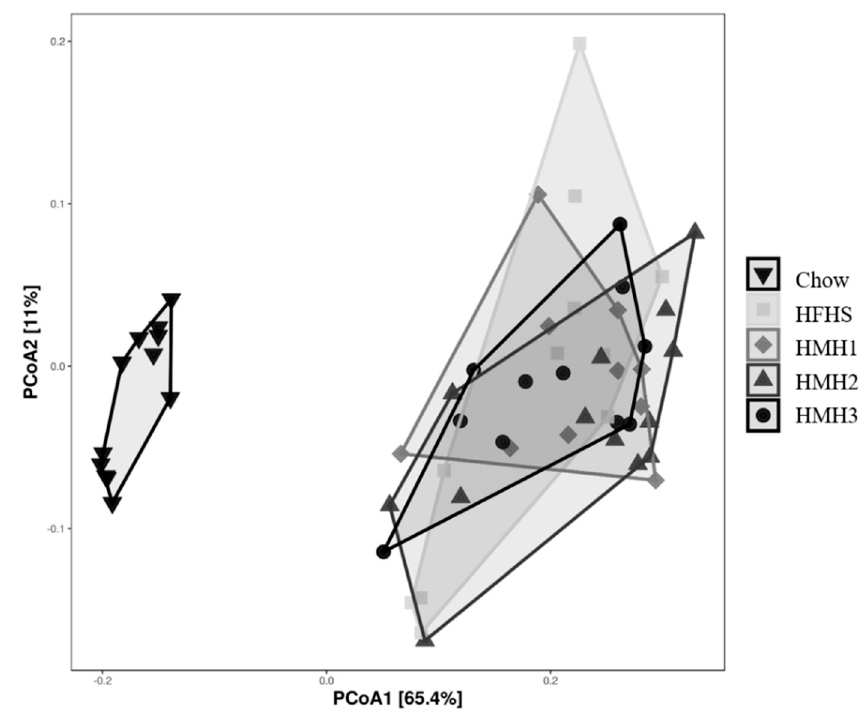
Figure 2. None of the HMH treatments impacted the global structure (Beta-diversity) of the gut microbiota after 8 weeks, as reflected by the principal coordinates analysis (PcoA) on the weighted UniFrac distance matrix. ( n = 11 − 12).